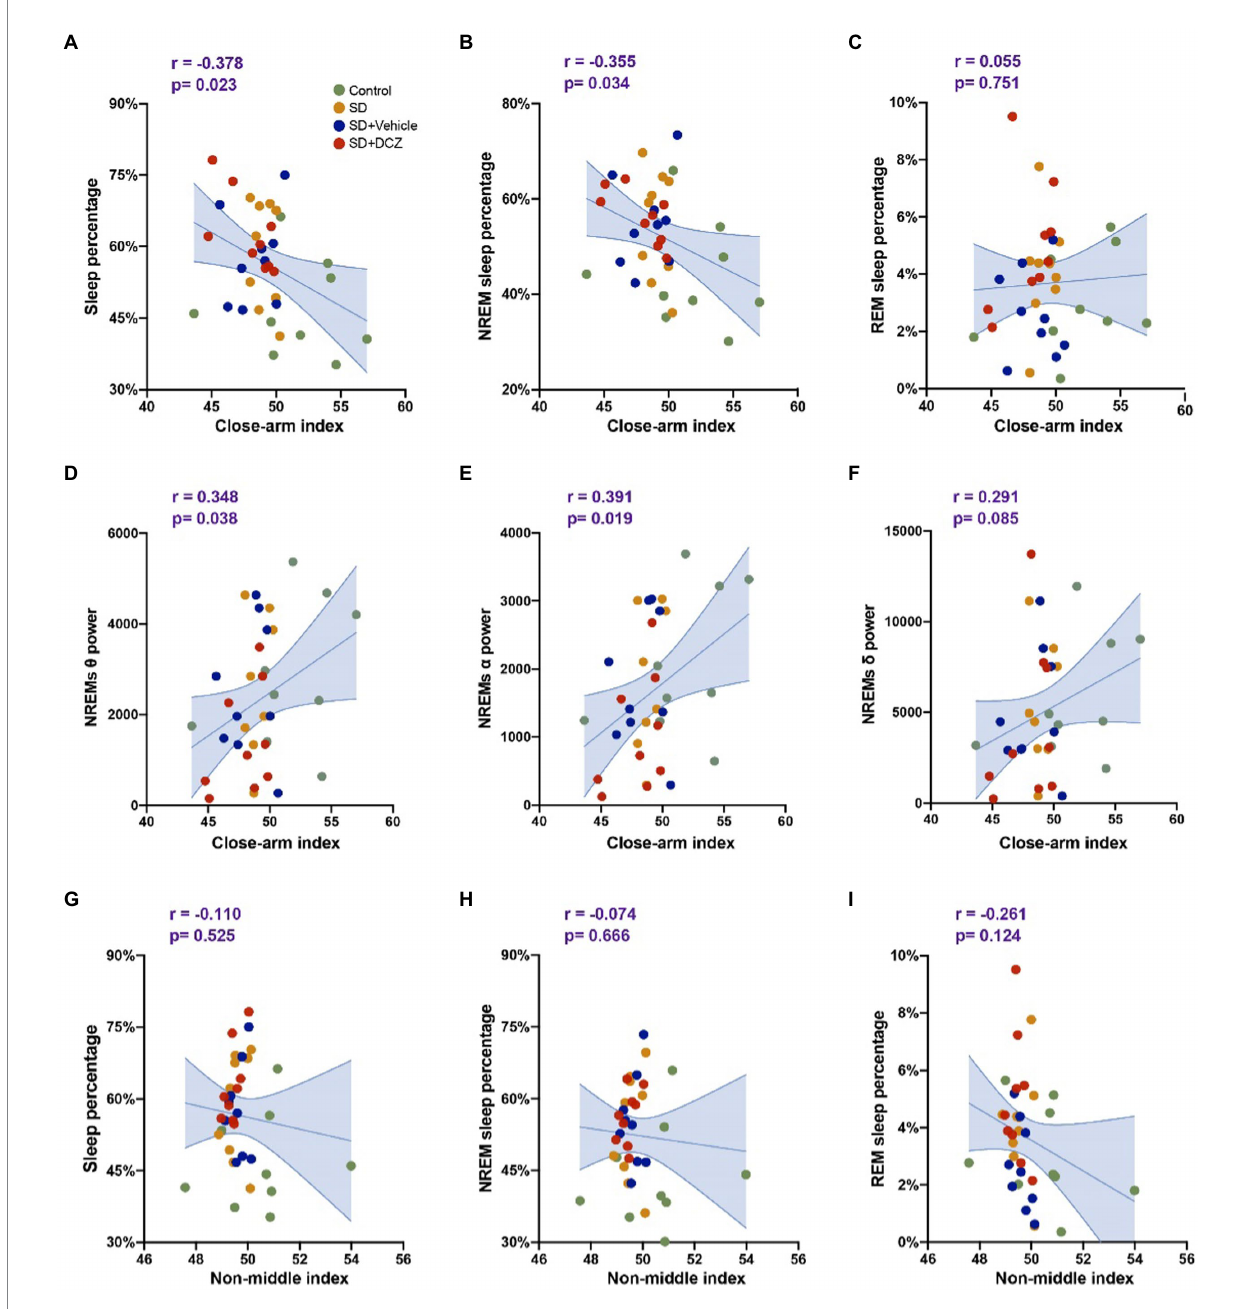
FIGURE 7 Sleep structures are correlated with anxiety state. (A–C) Correlation analysis between close arm index calculated by EPM results and sleep percentage, NREMs percentage, and REMs percentage. (D–F) Correlation analysis between close arm index and theta, alpha, and delta powers of NREMs. (G–I) Correlation analysis between non-middle index calculated by OFT results and sleep percentage, NREMs percentage, and REMs percentage. Shaded area: 95% confidence